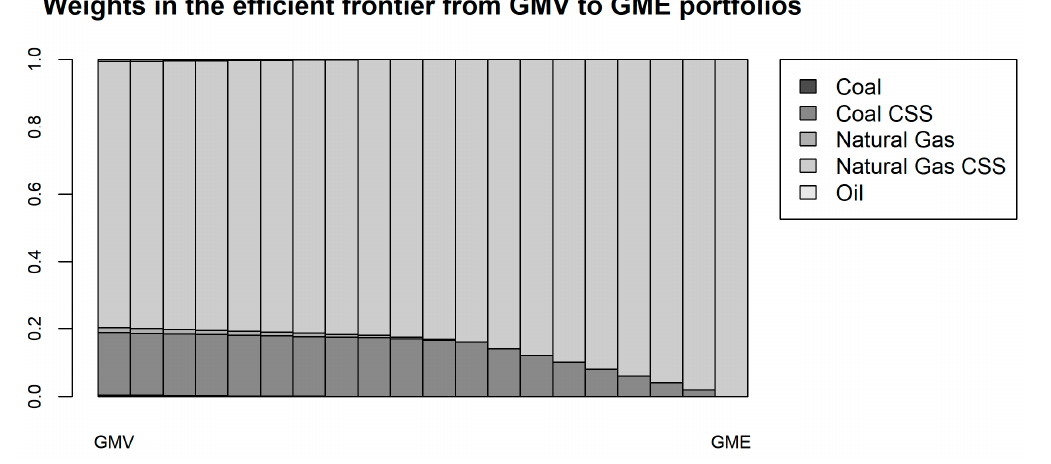
Figure 4. Non-pollutant technology model’s efficient frontier.